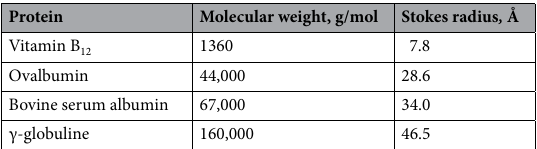
ing bath for ~ 3 h. Then the membrane was washed three times with an aqueous solution of ethanol, hexane and dried. The dynamic viscosity of P84 and P84/IL casting solutions in NMP was measured using a vibration viscometer SV-10A, A&D (Japan) with a measuring range of 0.3–10,000 mPa s. The measurement was carried out at 25 °C. Computational details. The full geometry optimization of all model structures was carried out at the DFT level of theory using the dispersion-corrected hybrid functional ωB97XD 45 with the help of Gaussian-09 program package 46 . The standard 6-31G* basis sets were used for all atoms. No symmetry restrictions have been applied during the geometry optimization procedure. The Hessian matrices were calculated analytically for opti- mized model structures to prove the location of correct minima on the potential energy surfaces (no imaginary frequencies were found in all cases). The thermodynamic parameters were calculated at 298.15 K and 1.00 atm. The enthalpies, entropies, and Gibbs free energies of optimized equilibrium model structures are presented in Tables S1. Detailed description of enthalpies, entropies, and Gibbs free energies calculations procedure is given in 22 . Membrane characterization. Ultrafiltration tests were carried out in the dead-end cell with a membrane diameter of 25 mm equipped with a stirrer with a speed of 200 – 600 rpm, a transmembrane pressure was main- tained at ~ 1 bar by nitrogen flow 47 . The filtrate (permeate) amount was determined using electronic balance. Membrane calibration was carried out according to the technique described in 48 . UF test was performed using 1 wt% mixture of proteins with different molecular weight (Table 1) in a phosphate buffer solution, pH 7. The concentration of the proteins in the feed and permeate was analyzed using a PE-5400UF spectrophotometer (Ekroschem, St. Petersburg, Russia). The measurements were carried out at a wavelength of 280 nm since it is the maximum absorption of the selected proteins. To estimate separation efficiency of membranes toward La 3+ , a solution of lanthanum—alizarin complex (LAC) was prepared from the following components: 2 cm 3 of an acetate buffer solution, 10 cm 3 of a lanthanum nitrate solution with a concentration of 5 mmol/dm 3 , 10 cm 3 of an alizarin complexone solution (5 mmol/dm 3 ) and 25 cm 3 of acetone. Being thorough mixed, 20 cm 3 of the prepared solution was taken with a calibrated pipette and transferred to a volumetric flask of 100 cm 3 . The concentration of LAC in the permeate and feed was determined using a KFK-ZKM photoelectric concen- tration colorimeter (Unico-Sis, St. Petersburg, Russia) (a light filter with a maximum transmission of 590 ± 10 nm and a bandwidth of 25 ± 10 nm). The data of UF experiments were used to calculate the transport properties of the membranes. The flux through the membranes, J (L m −2 h −1 bar −1 ), was calculated as: